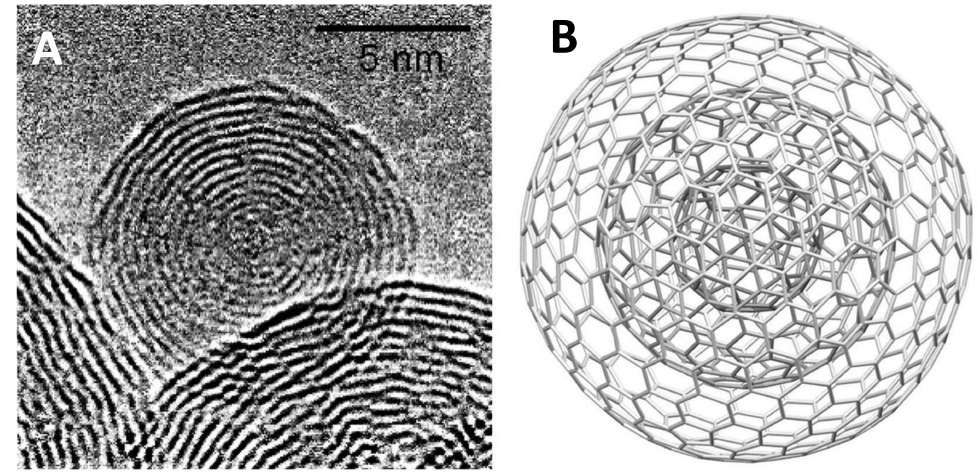
Figure 8. High-resolution TEM image of ( A ): Carbon onion; ( B ): Structure of carbon onion. Repro- duced with permission from reference